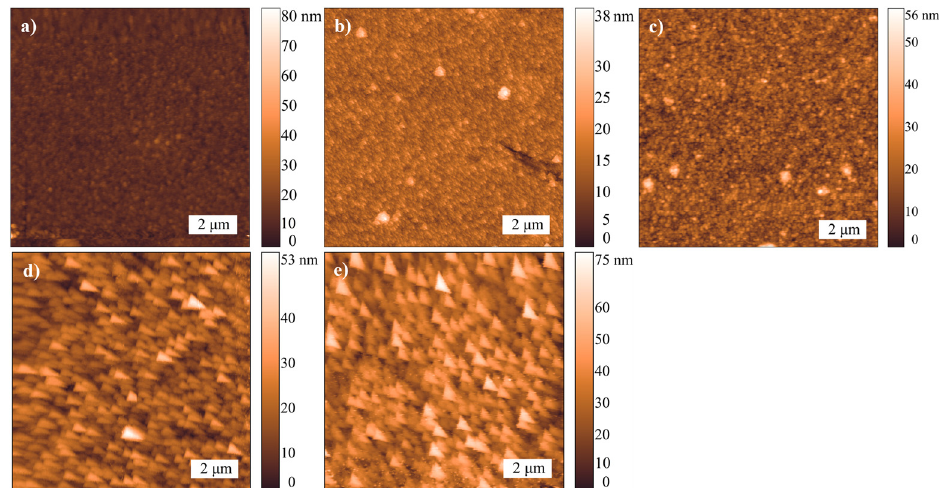
Figure 1. AFM topography images of ScAlSZ thin films deposited using a 0.4 nm/s deposition rate